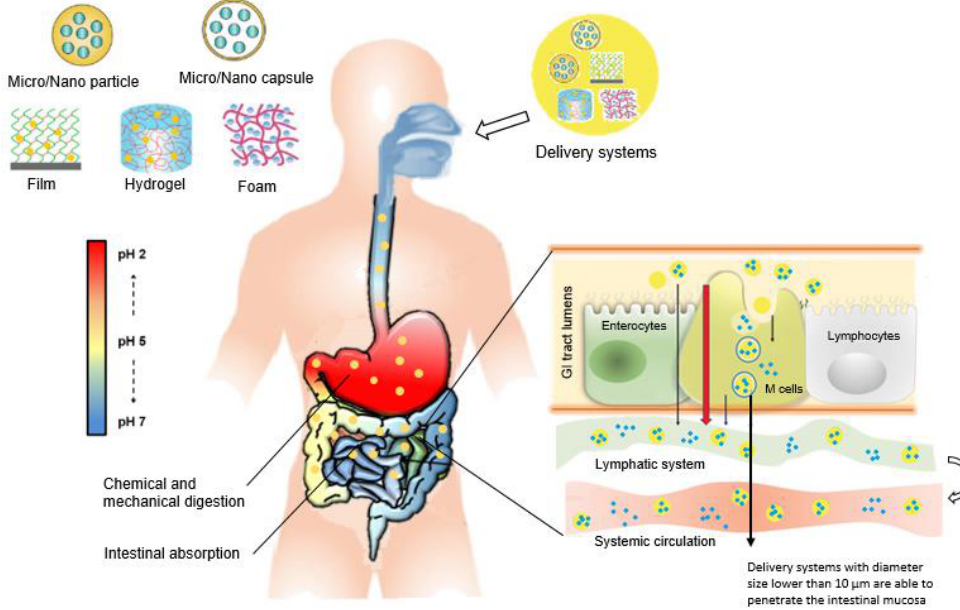
Figure 7. Schematic overview of the gastrointestinal fate of micro and nano delivery systems Adapted with permission [234,235], 2020, Elsevier.